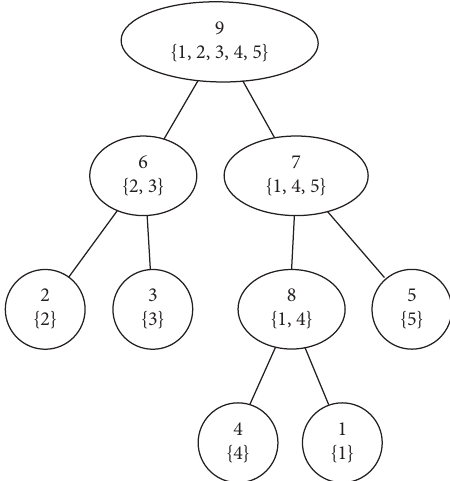
Figure 6: Correspond hierarchical modularization tree for 8 , 6 , 6 , 8 , 7 , 9 , 7 Prufer